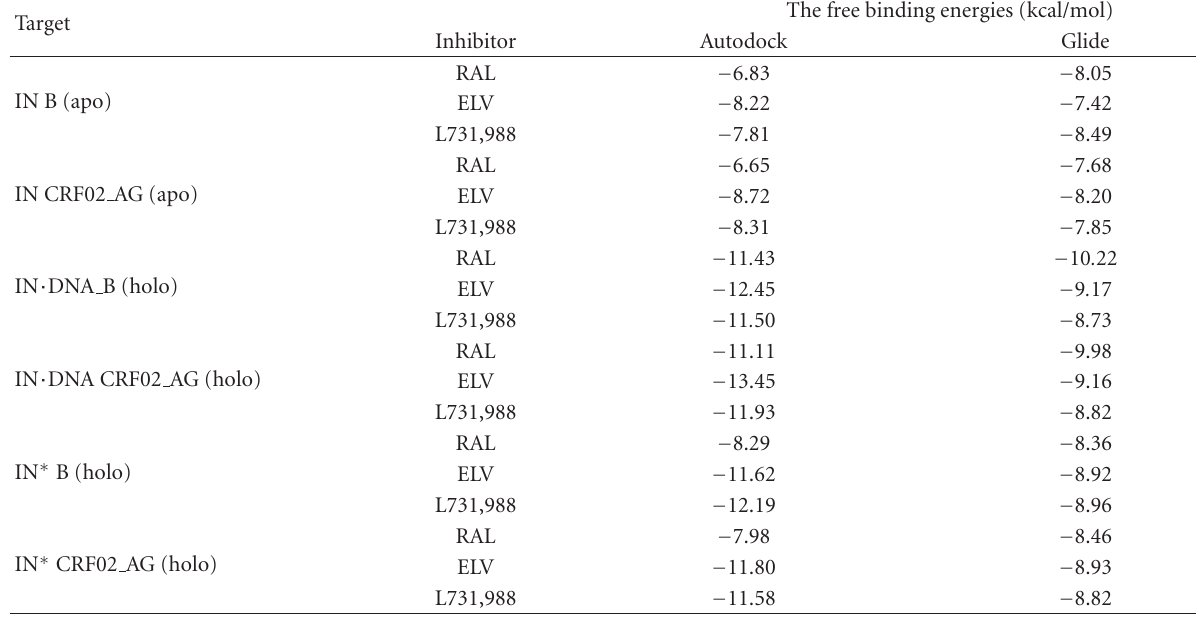
Table 2: Docking binding energies of RAL, ELV and L731,988 on the HIV-1 IN from B and CRF02 AG strains predicted by Autodock and Glide. The targets are the IN model with one Mg 2+ cation in the active site (apo state, models 1 and 2) and IN · DNA model with two Mg 2+ cations (holo state, models 3 and